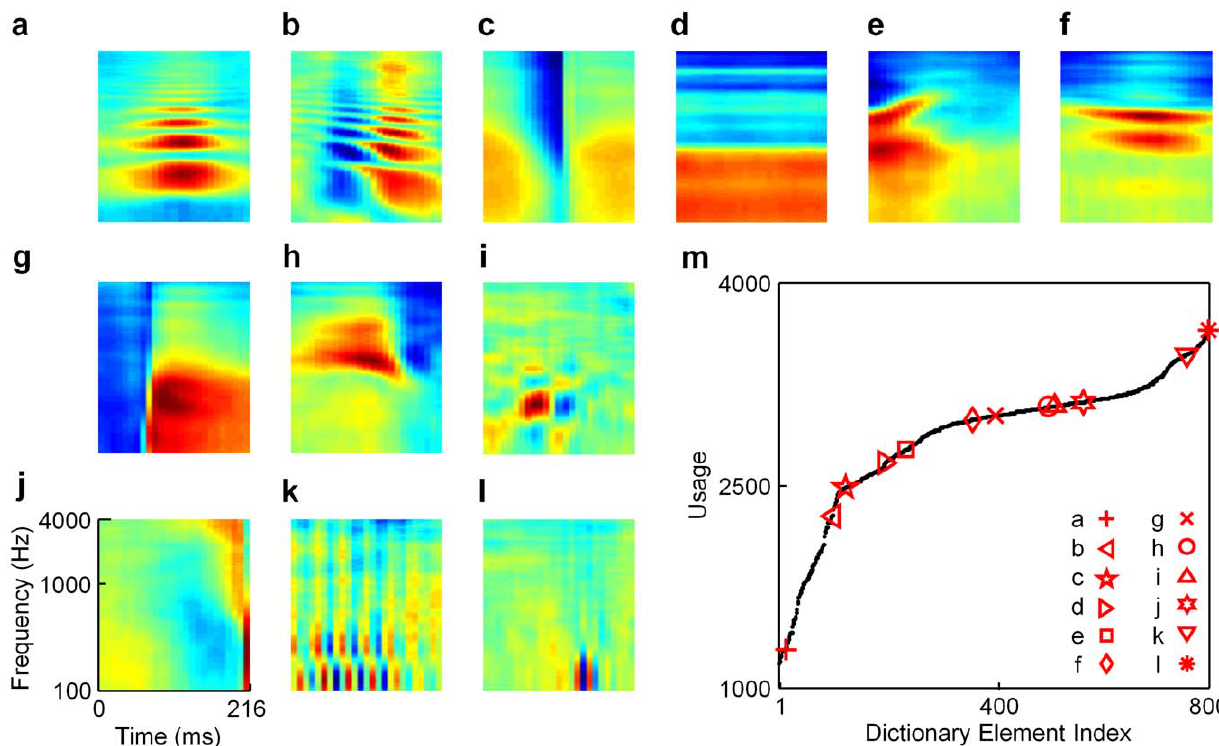
Figure 4. A four-times overcomplete, L0-sparse dictionary trained on speech spectrograms. This dictionary shows a greater diversity of shapes than the undercomplete dictionaries. ( a–l ) Representative elements a , c , e , g , j , and l resemble those of the half-complete dictionary (see Fig. 3 ). Other neurons display more complex shapes than those found in less overcomplete dictionaries: ( b ) a harmonic stack with flanking suppressive subregions; ( d ) a neuron sensitive to lower frequencies; ( f ) a short harmonic stack; ( h ) a localized but complex pattern of excitation with flanking suppression; ( i ) a localized checkerboard with larger excitatory and suppressive subregions than those in panel l ; ( k ) a checkerboard pattern that extends for many cycles in time. Several of these patterns resemble neural spectro-temporal receptive fields (STRFs) reported in various stages of the auditory pathway that have not been predicted by previous theoretical models (see text and Figs. 6–8 ). ( m ) A graph of usage of the dictionary elements during inference. The different classes of dictionary elements still separate according to usage (see Fig. S4 for the full dictionary) although the notable rises and plateaus as seen in Fig. 3g are less apparent in this larger dictionary.